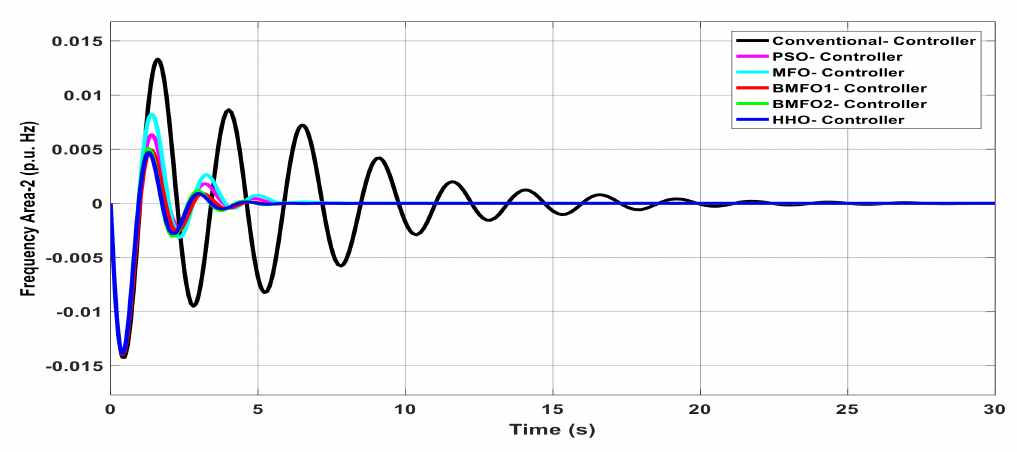
Figure 16. Dynamic response of Area2 frequency with various controller under contract violation case.